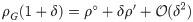
Classifying the effects of graph structure on weak selection.(A) The fixation probability ρG(r), for a mutation of fitness r on a graph G, can be expanded under weak selection as ρG(1+δ)=ρ∘+δρ′+O(δ2). The zeroth-order coefficient, ρ∘, is the fixation probability of a neutral mutation, while the first-order coefficient, ρ′, determines the effect of weak selection. (B) The effects of graph structure on weak selection can be classified using ρ∘ and ρ′. All isothermal graphs (black dot) have ρ∘ = 1/N and ρ′ = (N − 1)/(2N). We say a graph is an absolute amplifier if ρ′ > (N − 1)/(2N), and an absolute suppressor if ρ′ < (N − 1)/(2N). We say a graph is a relative amplifier if ρ′/ρ∘ > (N − 1)/2 and a relative suppressor if ρ′/ρ∘ < (N − 1)/2. The three possible combinations for temperature initialization are shown in the colored regions.